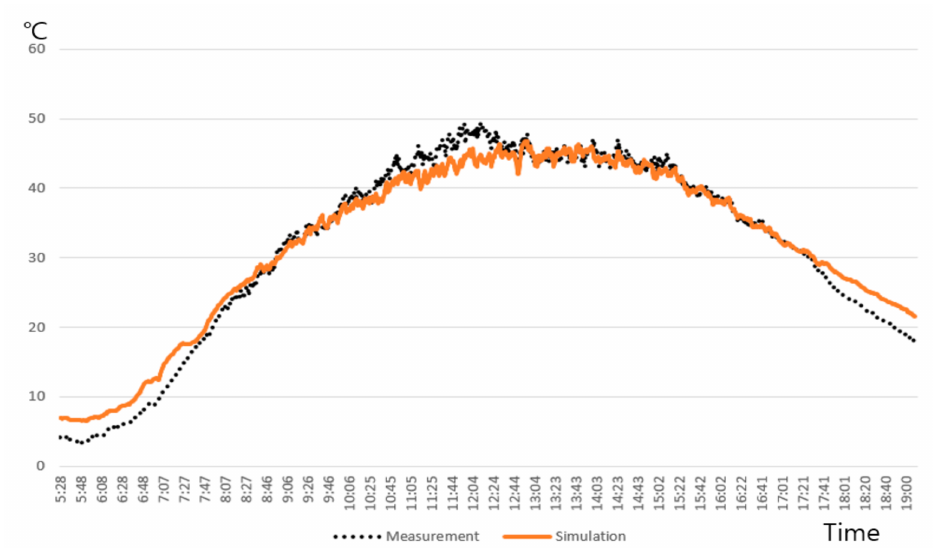
Figure 5. Photovoltaic (PV) module temperature graph showing measurement and prediction (05 May